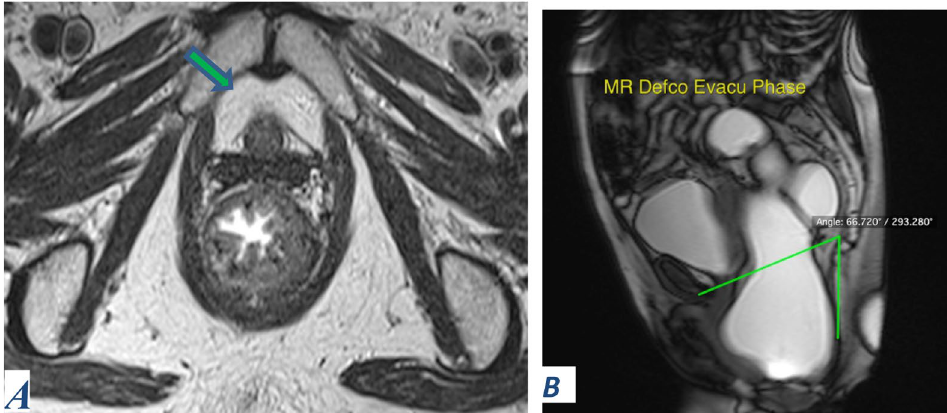
Fig. 6 A 51-year-old woman with 1st presentation of stress urinary incontinence showing: A Static axial T2-weighted TSE MR image showing the “drooping moustache sign,” due to level III endopelvic fascial defect (green arrows). B Sagittal dynamic image of the same patient showing increased LPA denoting pelvic floor muscle weakness (the levator plate angle, is defined as the angle enclosed between the pubococcygeal line and the levator plate (green line)